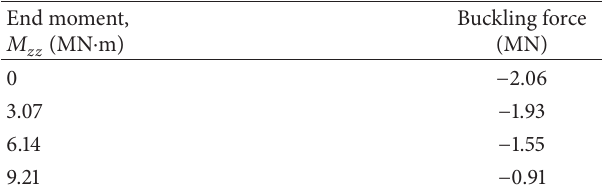
Table 6: Critical buckling compressive force for cantilevered boundary condition with varying end moment (5-element DFE model).